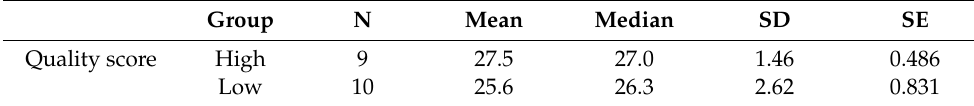
Table 6. Descriptive statistics of the reporting standard guidelines